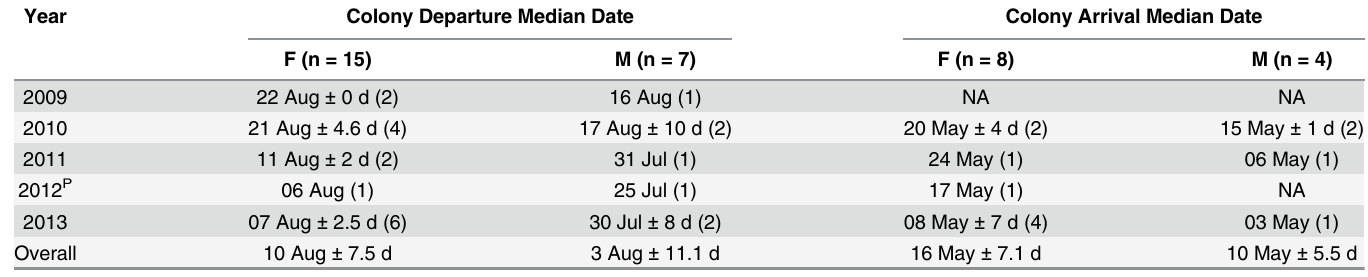
Table 2. Summary of colony departure and arrival dates of individually tracked murres (wet-dry log). Values are median dates ( ± SD days) summa- rized by sex (and year where sample size allows).